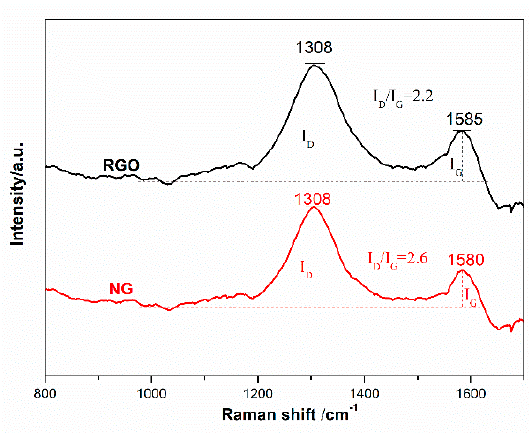
Figure 5. Raman spectra of NG and RGO.